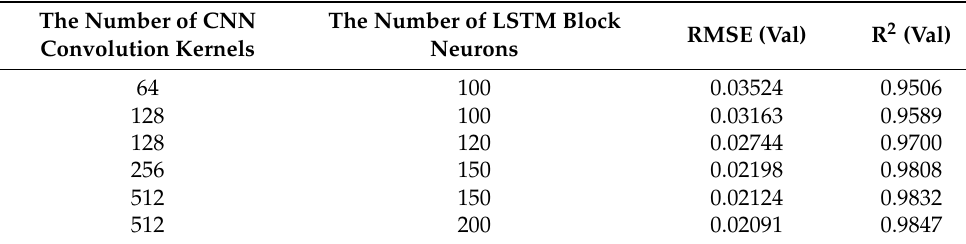
Table 2. Experiment results comparing the number of different CNN convolution kernels and LSTM block neurons.